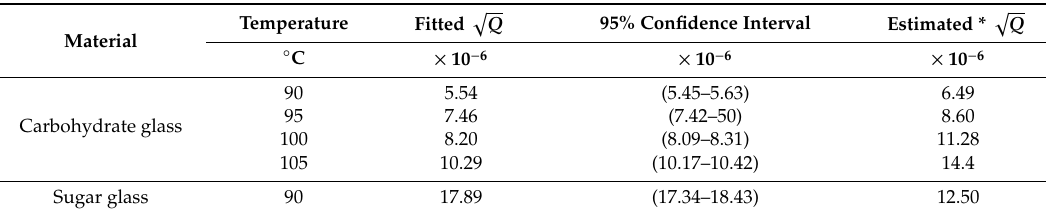
Table 2. Fitted (with Equation (1)) and estimated values (with Equation (2)) for glass at di ff erent temperatures, as well as the sugar